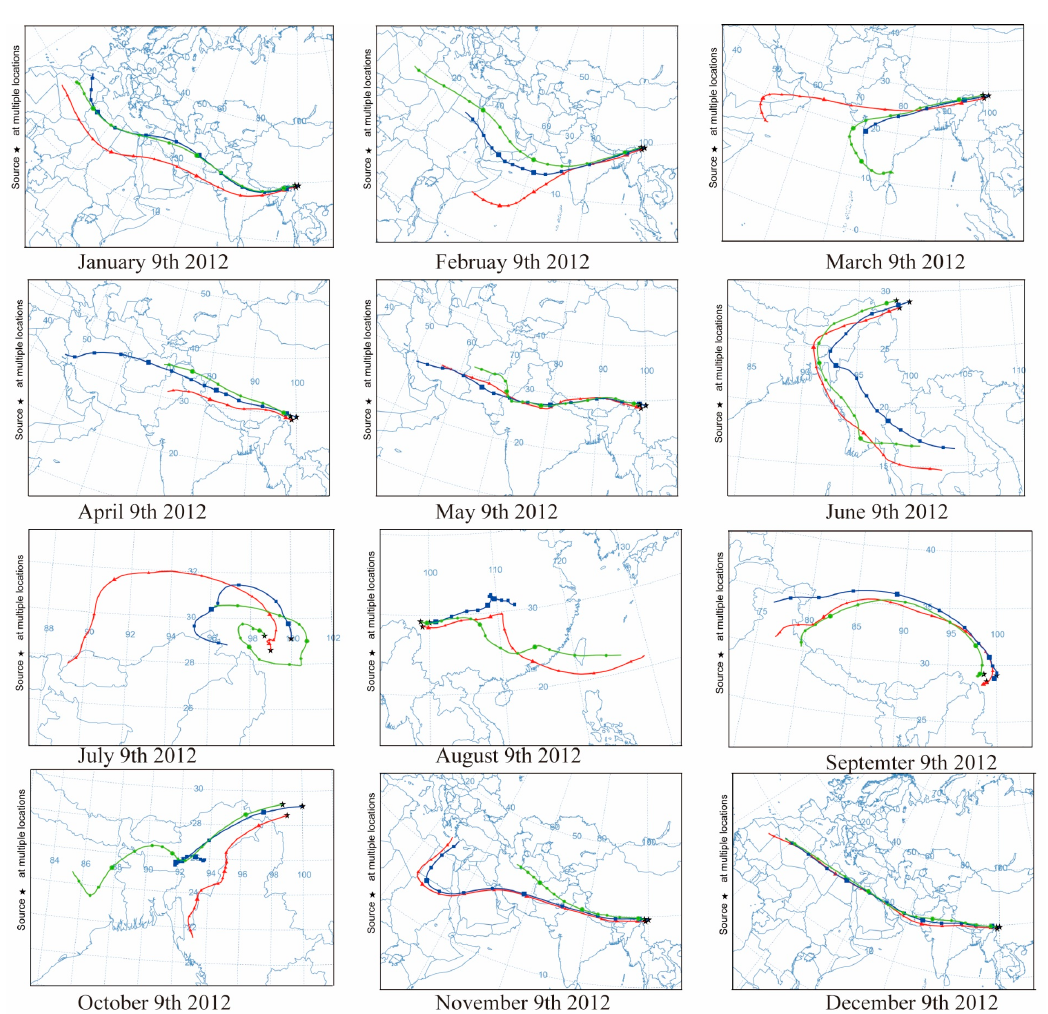
Figure 4. The 72 h backward trajectories of the sampling period of the study area from January to December 2012 (https://ready.arl.noaa.gov/hypub-bin/trajtype.pl?runtype=archive).